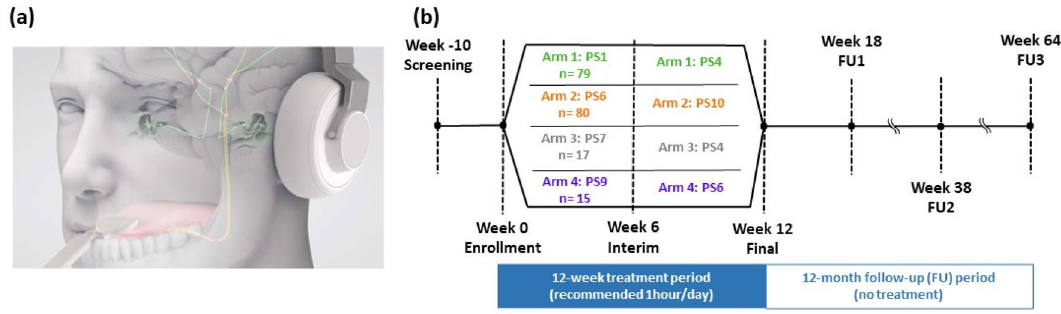
Figure 1. Timeline of different parameter settings for tinnitus treatment in the TENT-A2 study. ( a ) The Lenire bimodal neuromodulation device developed by Neuromod Devices is shown (CE-marked Class IIa; previously referred to as MBT in the study). Sound stimulation is delivered through wireless headphones and electrical stimulation is presented to the anterior-dorsal surface of the tongue via a 32-site electrode array. Both stimulation approaches are controlled using a battery-powered controller. Bimodal stimulation activates auditory and somatosensory pathways, as well as converging centers in auditory, limbic and attentional brain regions implicated in tinnitus. ( b ) Timeline of four treatment arms with different stimulation parameters over time (see Supplementary Table S1 for detailed description). Arm 1 and arm 2 are included for the primary endpoint analyses. Arm 3 and arm 4 are included for additional analyses. Evaluations of device safety and efficacy were conducted at interim and final visits with post-treatment follow-ups planned at weeks 18, 38 and 64 from